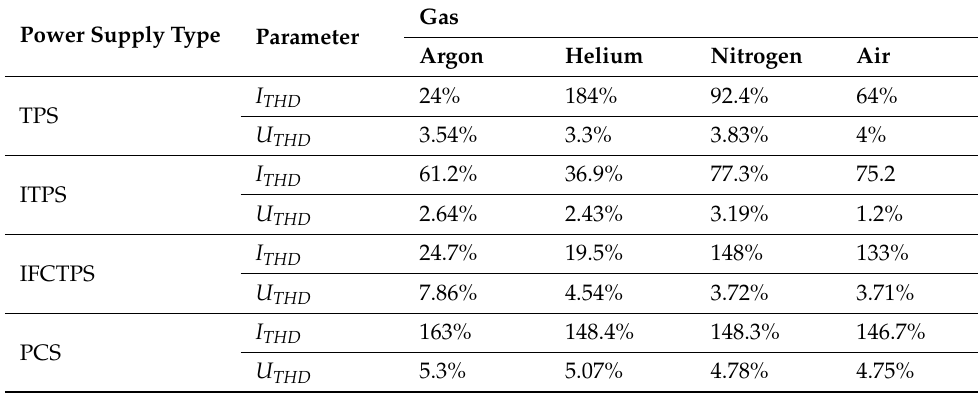
Table 8. Harmonic content